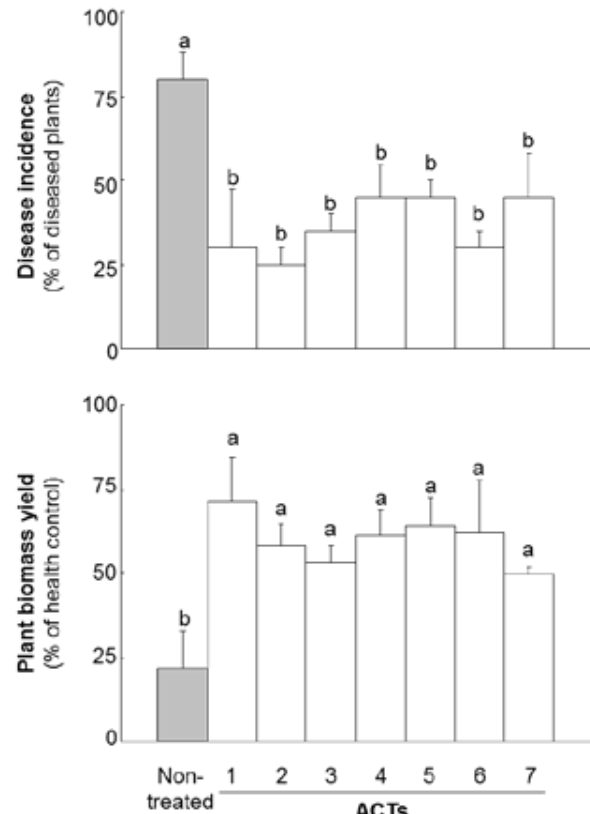
Figure 5. Mean disease incidence and mean plant biomass (±1 SE) for pepper plants drenched with different aerated compost teas (ACTs), growing in media inoculated with Sclerotium rolfsii. Different letters indicate significant dif- ferences ( P ≤0.05) according to Duncan’s